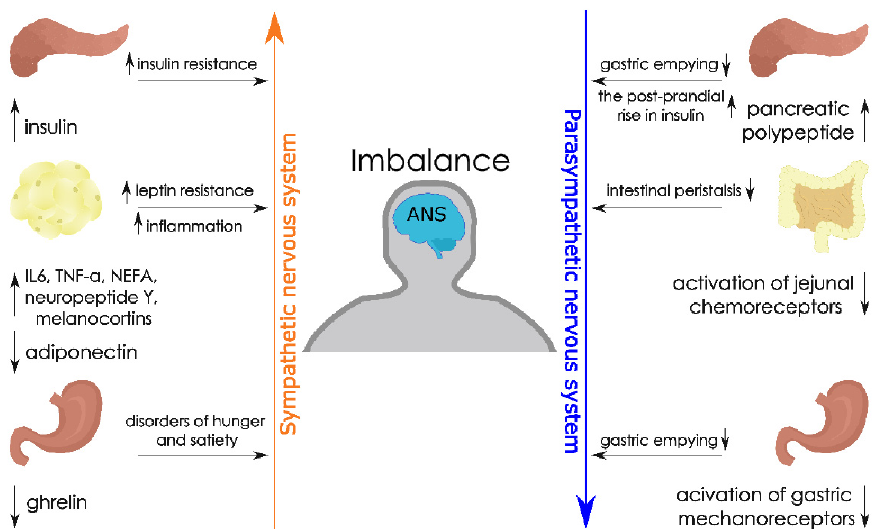
Figure 2. The possible imbalance of the sympathetic and parasympathetic branches of the autonomic nervous system, which may contribute to the dysfunction of the lymphatic system in the course of obesity. The figure prepared by Klaudia Antoniak on the basis of [45,49,53,70]. Abbreviations: ↑ — increase, ↓ — decrease, ANS (Autonomic Nervous System); TNF- α (tumor necrosis factor- α ); IL-6 (Interleukin-6); NEFA (non-esterified free fatty acids).